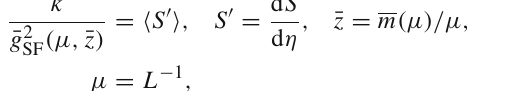
perturbative decoupling of the QCD parameters [33,74–79] needs to be extended also to such